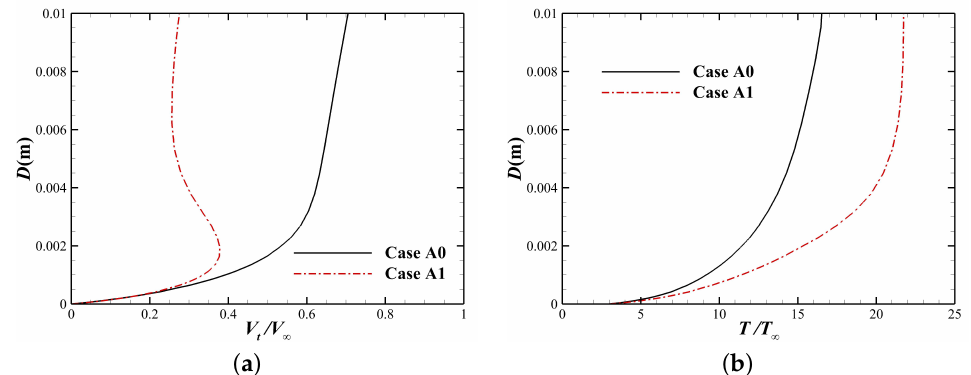
Figure 17. Boundary layer profiles at Station 2: ( a ) Tangential velocity. ( b ) Temperature.